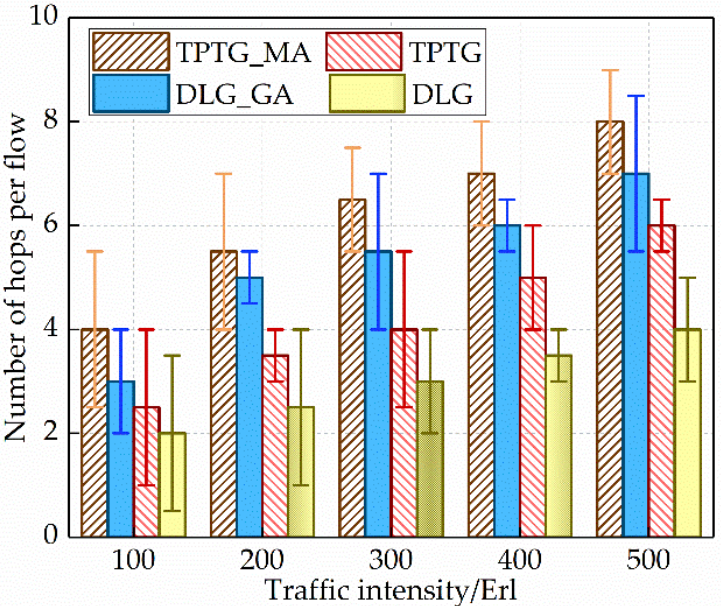
Figure 6. Comparison of the number of hops per-flow between the DLG, TPTG, DLG_GA, and TPTG_MA.